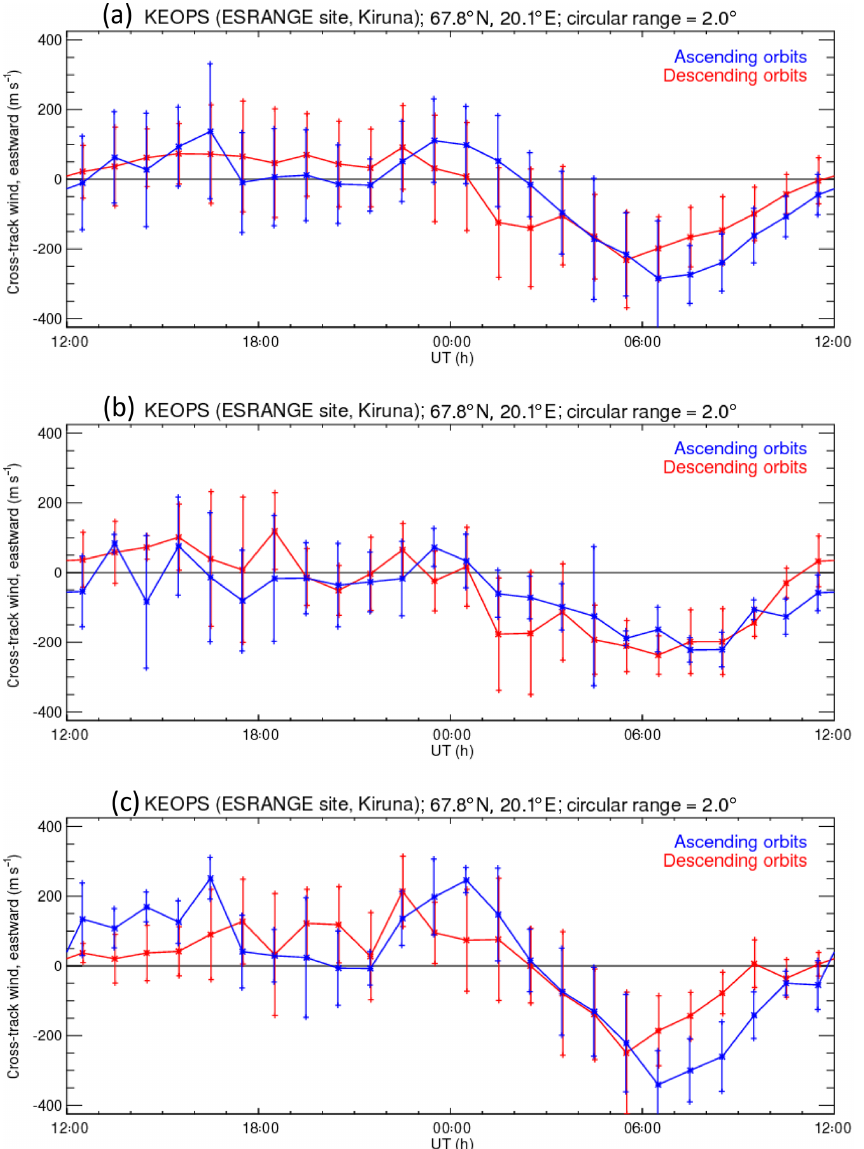
Figure 5. CHAMP observations over KEOPS during solar minimum 2005–2007. Panel (a) shows the average values for all data – ascend- ing (blue) and descending (red), panel (b) shows summer (May–August) averages and panel (c) shows winter (end October–early March)